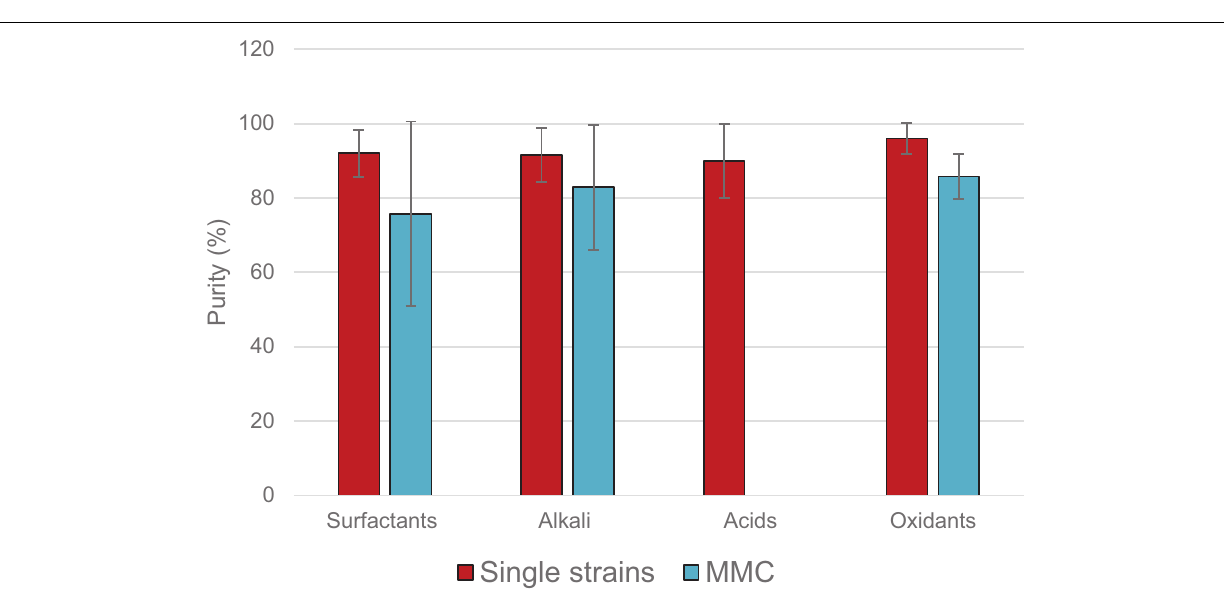
FIGURE 9 | Mean PHA purity (%) achieved through cellular lysis (with surfactants, alkali, acids, and oxidants) from single strains or